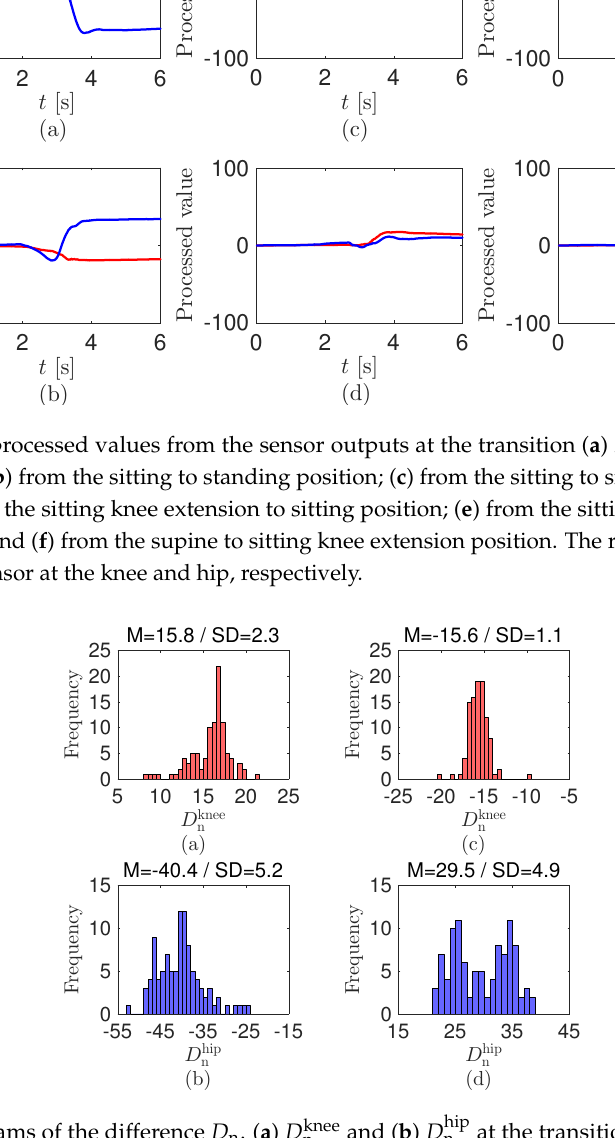
Figure 7. Histograms of the difference D n . ( a ) D knee n and ( b ) D hip n at the transition from the standing to sitting. ( c ) D knee n and ( d ) D hip n at the transition from the sitting to standing. “M” and “SD” indicate their mean and standard